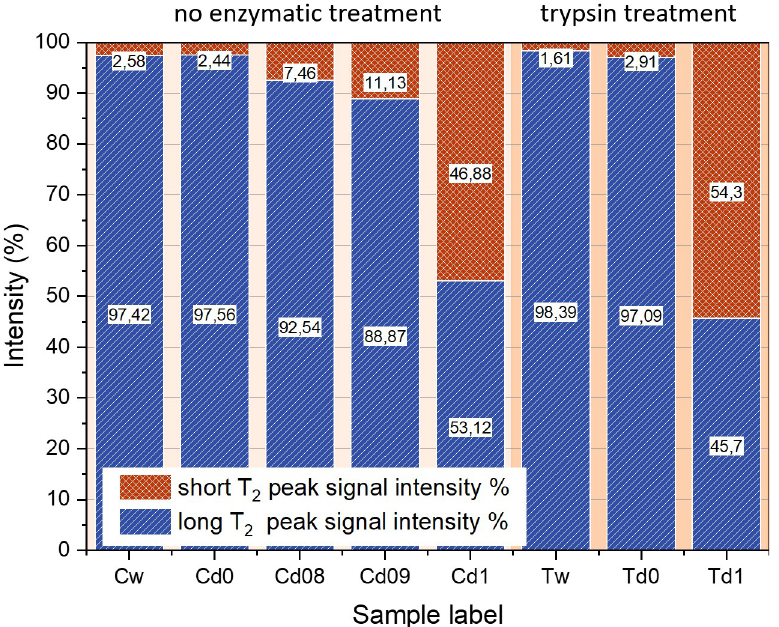
Fig 8. Relationship between the intensities of the two peaks identified in the 1 H T 1 -T 2 maps, as the sample is untreated or rehydrated with solutions with increasing concentrations of D 2 O, including the trypsin treatment. https://doi.org/10.1371/journal.pone.0256177.g008 a factor of 42; the second due to reduction of the 1 H spin density in the sample, i.e. by a factor of 5, 10 and infinity, respectively. This is counteracted by a slight increase of rotational and